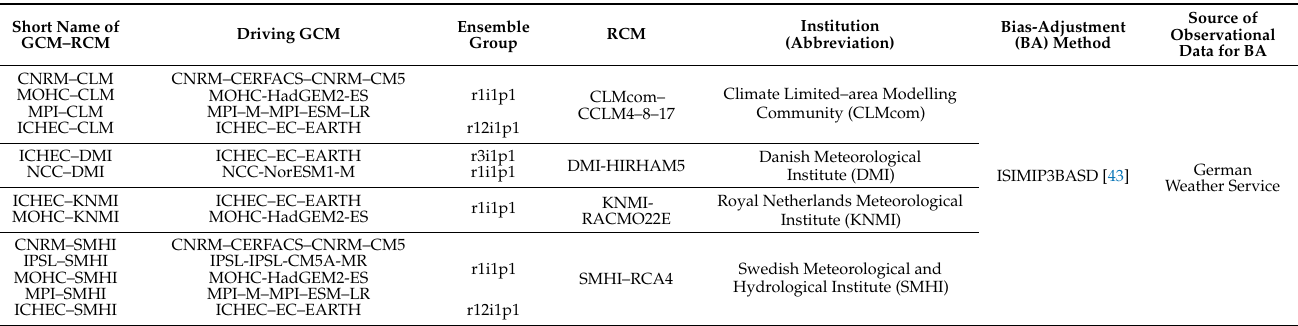
Table 2. List of used bias-adjusted global climate model–regional climate model (GCM–RCM) chains from